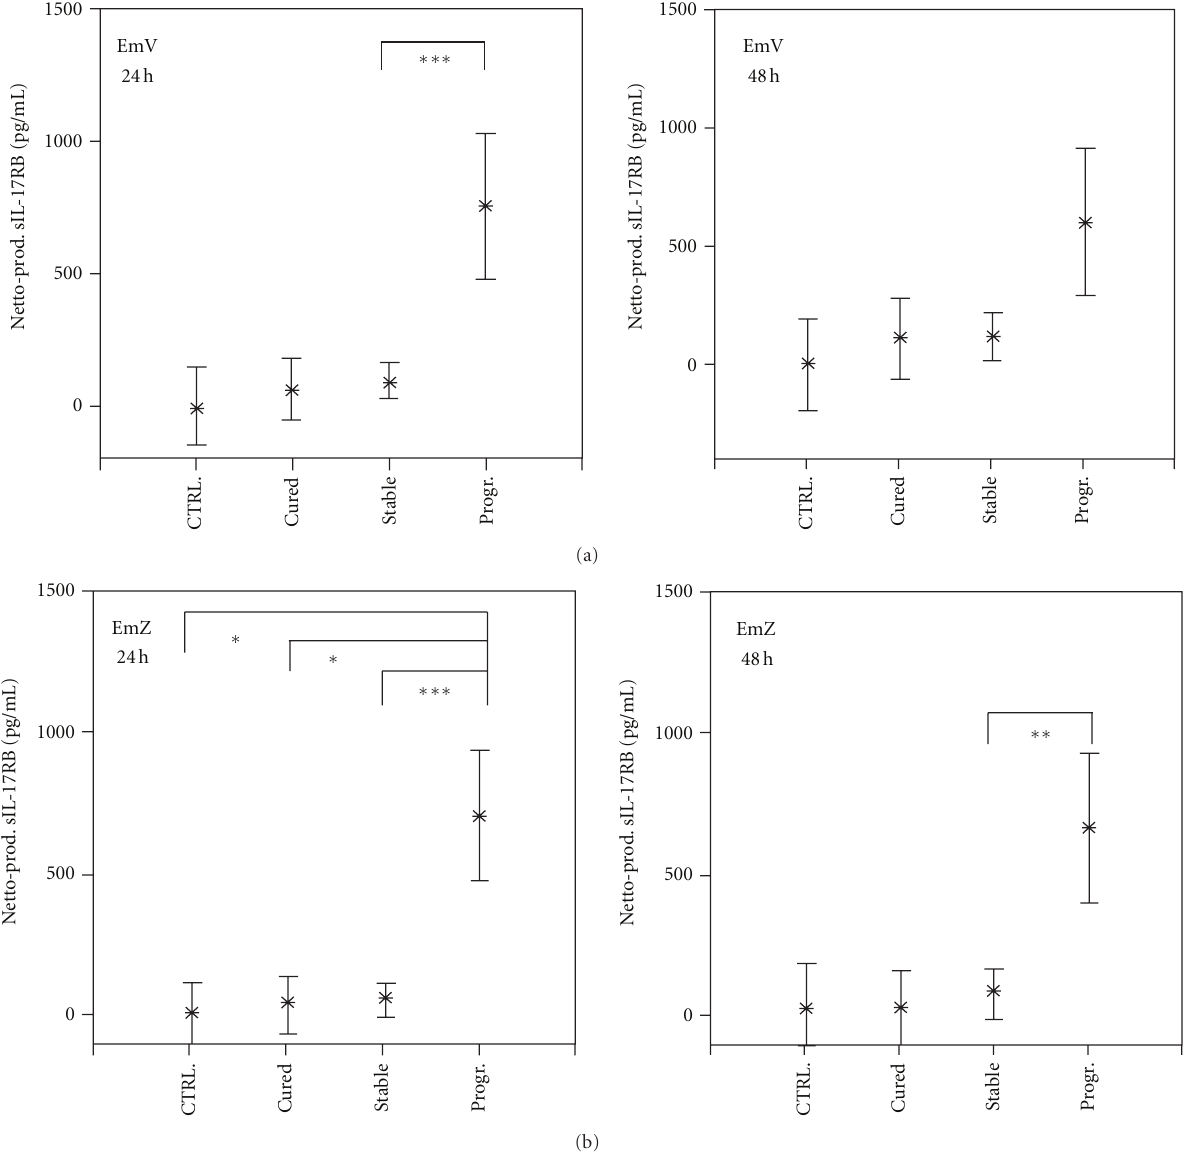
Figure 4: Echinococcus multilocularis antigen induced cellular production of soluble interleukin-17 receptor B (sIL-17RB) by PBMC from Alveolar Echinococcosis (AE) patients and infection-free controls (CTRL). Patients were grouped according to their state of infection, that is, cured, stable, or progressive (Prog.) Alveolar Echinococcosis. PBMCs from patients and controls were stimulated with Echinococcus multilocularis vesicle extract (EmV) (a) and single-cell extract (EmZ) (b) for 24 and 48 hours or left unstimulated. Cytokine concentrations in cell culture supernatant were determined by specific ELISA. The EmAg-induced cytokine production (Netto Prod.) was calculated by subtracting the cytokine production in not stimulated PBMC (Baseline) cultures from EmV-stimulated cytokine production (Brutto production). The cytokine production is shown as mean values in pg/mL with the 95% upper and lower confidence interval. The level of significance was adjusted by the Bonferroni-Holm method. The significant di ff erences between groups are indicated ( ∗ P < 0 . 05, ∗∗ P < 0 . 01, and ∗∗∗ P < 0 .